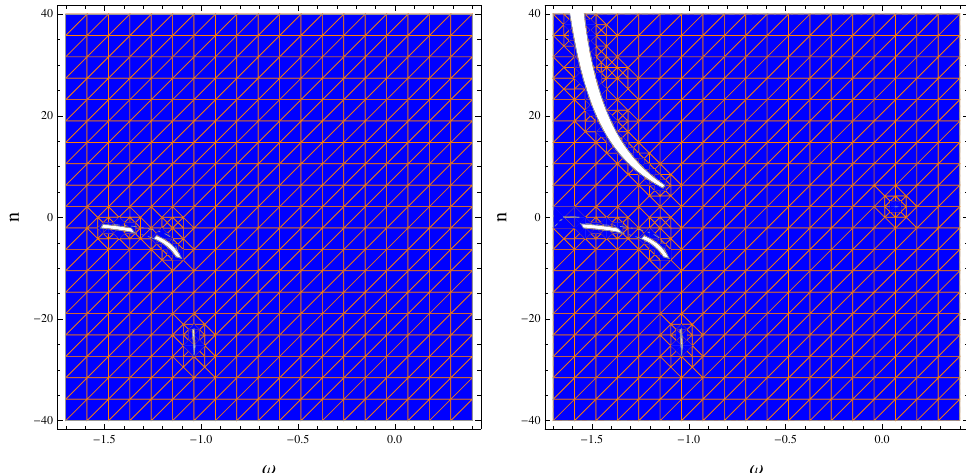
Figure 3. Stable regions of the ESU for K = − 1, λ = 2 (blue) and λ = 15 (orange), corresponding to η = 7 ( left ) and η = − 7 ( right ).